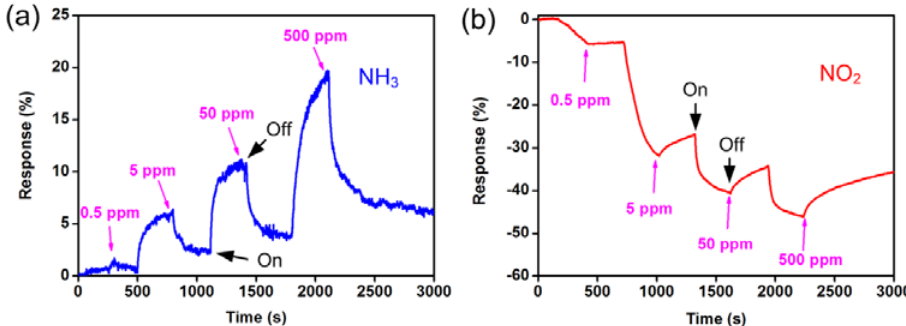
Figure 9. Performance of gas sensor devices based on the SWCNT networks grown with the nanoporous silica support layer. The sensor was sequentially exposed to 0.5 @500 ppm levels of ( a ) NH 3 and ( b ) NO 2 in nitrogen, “Reprinted/adapted with permission from Ref. [99]. 2012, copyright Han, Z.J. et al.”.